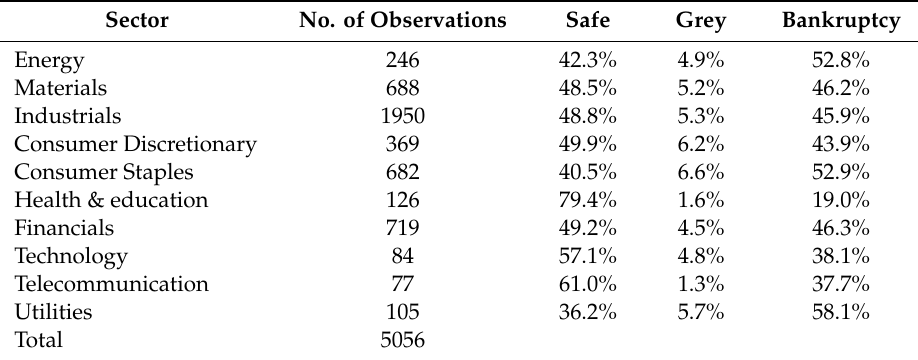
Table 11. Overall Distance to Default in all sectors for post-GFC (2010–2017). Sector No. of Observations Safe Grey